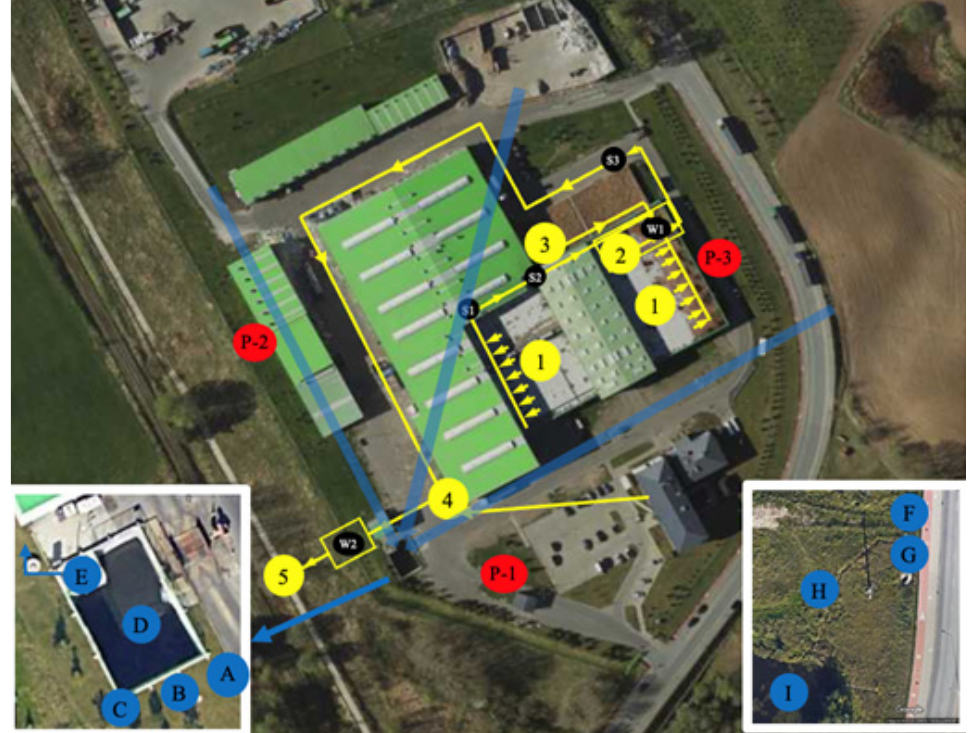
Figure 2. The wastewater system at the municipal waste disposal plant (ZUOK) in Olsztyn; source: maps.google.pl (accessed on 13 December 2022).